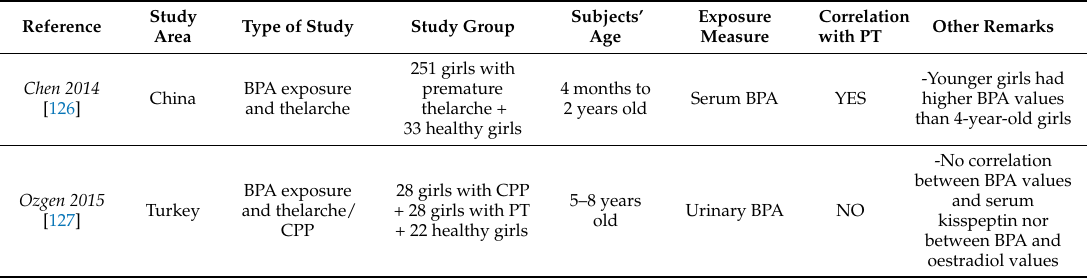
Table 2. Overview of epidemiological studies investigating the relationship between bishenol A (BPA) and isolated premature